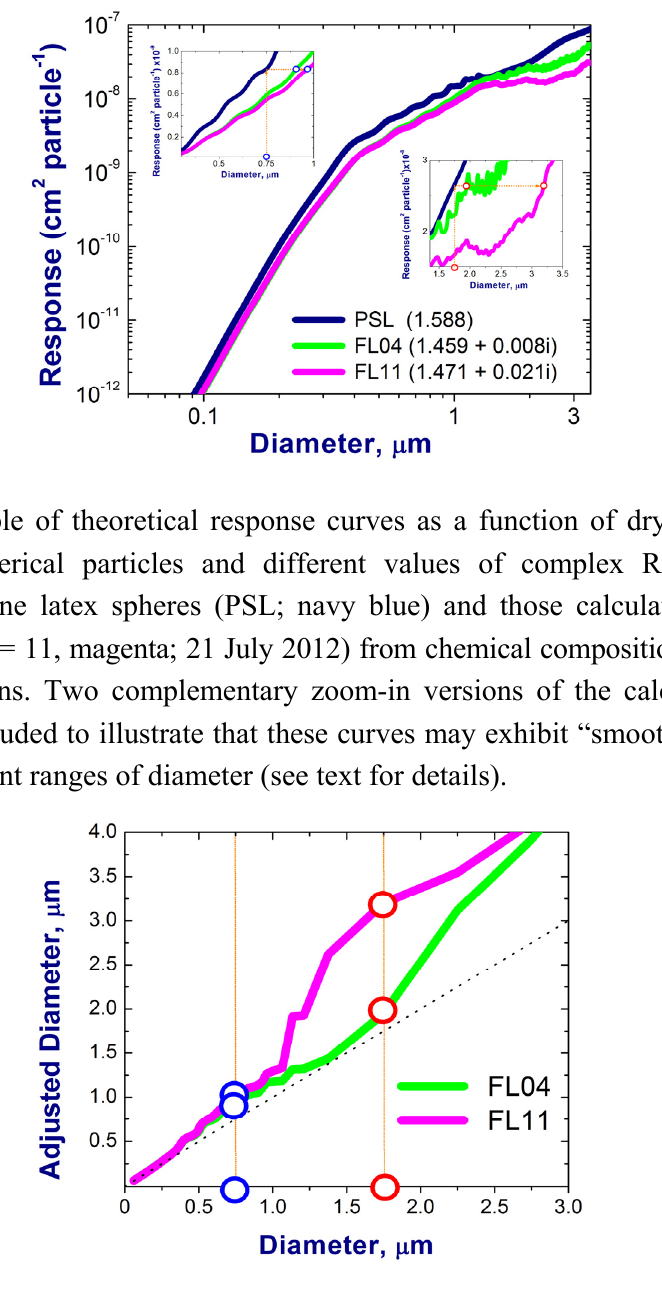
Figure C2. Adjusted dry diameter (D dry,adj ) as a function of original dry diameter (D dry ) obtained for two FLs (FL = 4, green; FL = 11, magenta; 21 July 2012) from the calculated response curves ( Figure